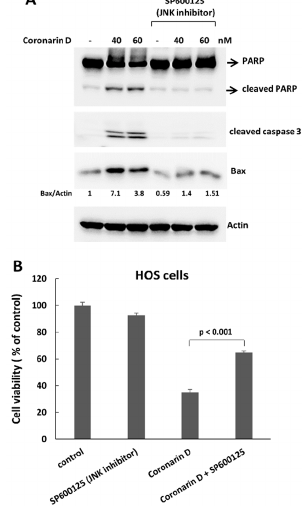
Figure 5. JNK inactivation inhibits coronarin D-induced cell death. ( A ) JNK inactivation suppresses coronarin D-induced cell death. HOS cells were pretreated with JNK inhibitor (SP600125) (20 μ M) for